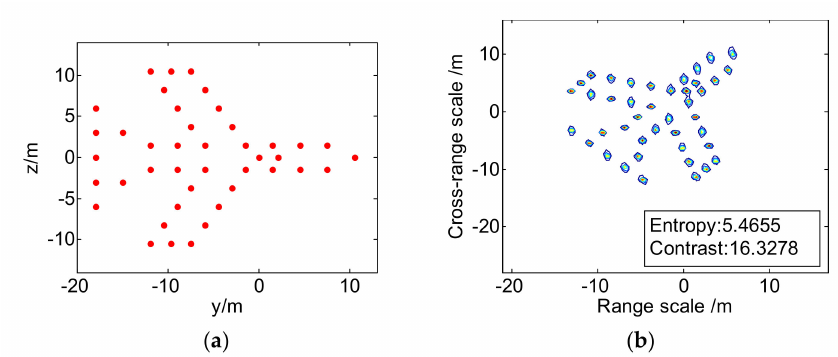
Figure 3. Target model and ISAR imaging result. ( a ) Target model; ( b ) ISAR image of target with smooth motion.